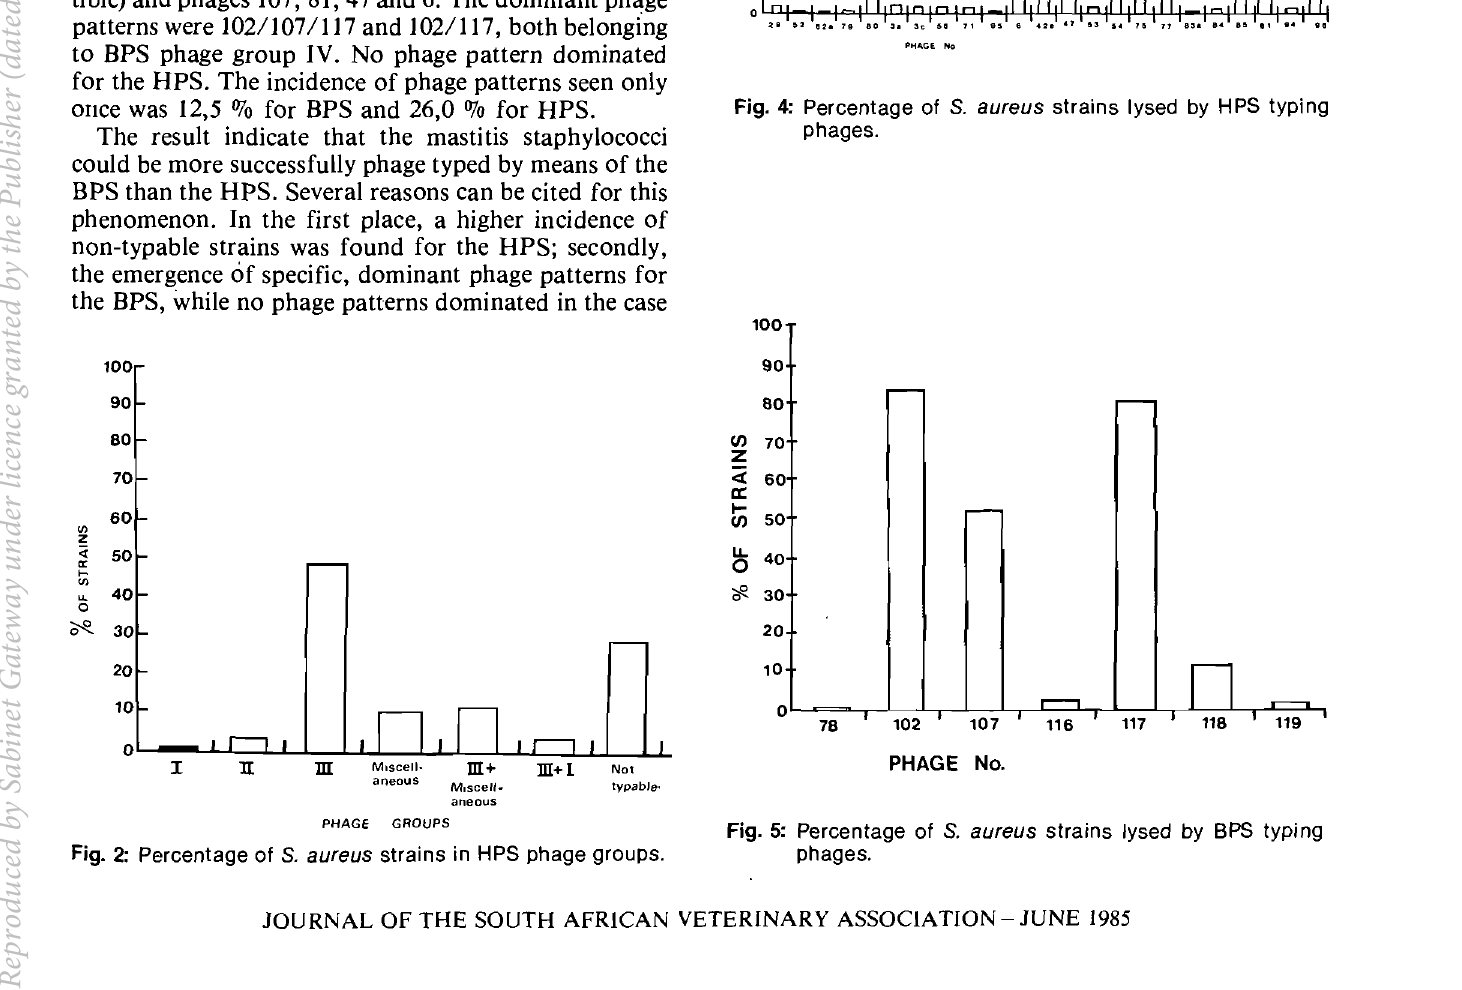
Fig. 4: Percentage of S. aureus strains lysed by HPS typing phages.